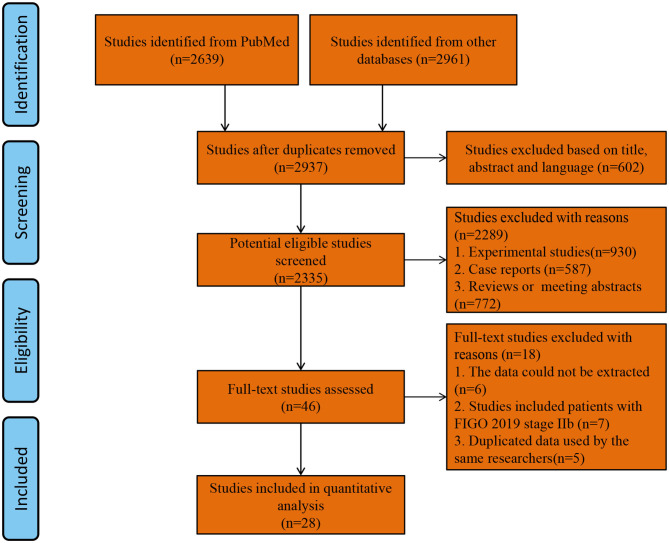
Flow diagram of the meta-analysis process.